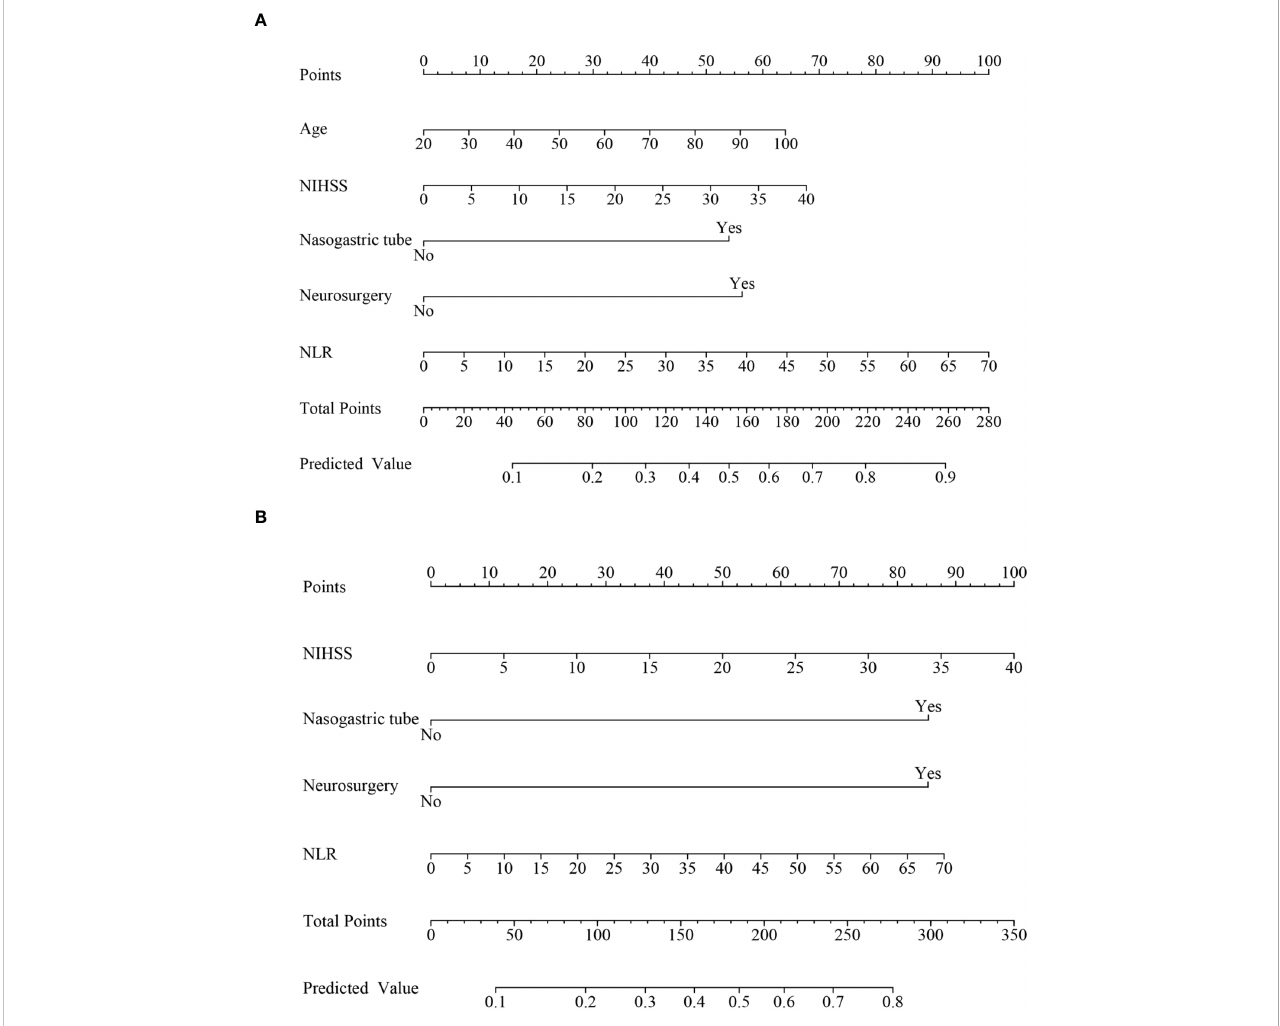
FIGURE 4 Nomogram to estimate the risk of SAP in patients with ICH. (A) Nomogram model to predict SAP occurrence. (B) Nomogram model to predict ICU admission. ICH, intracerebral hemorrhage; SAP, stroke-associated pneumonia; ICU, intensive care